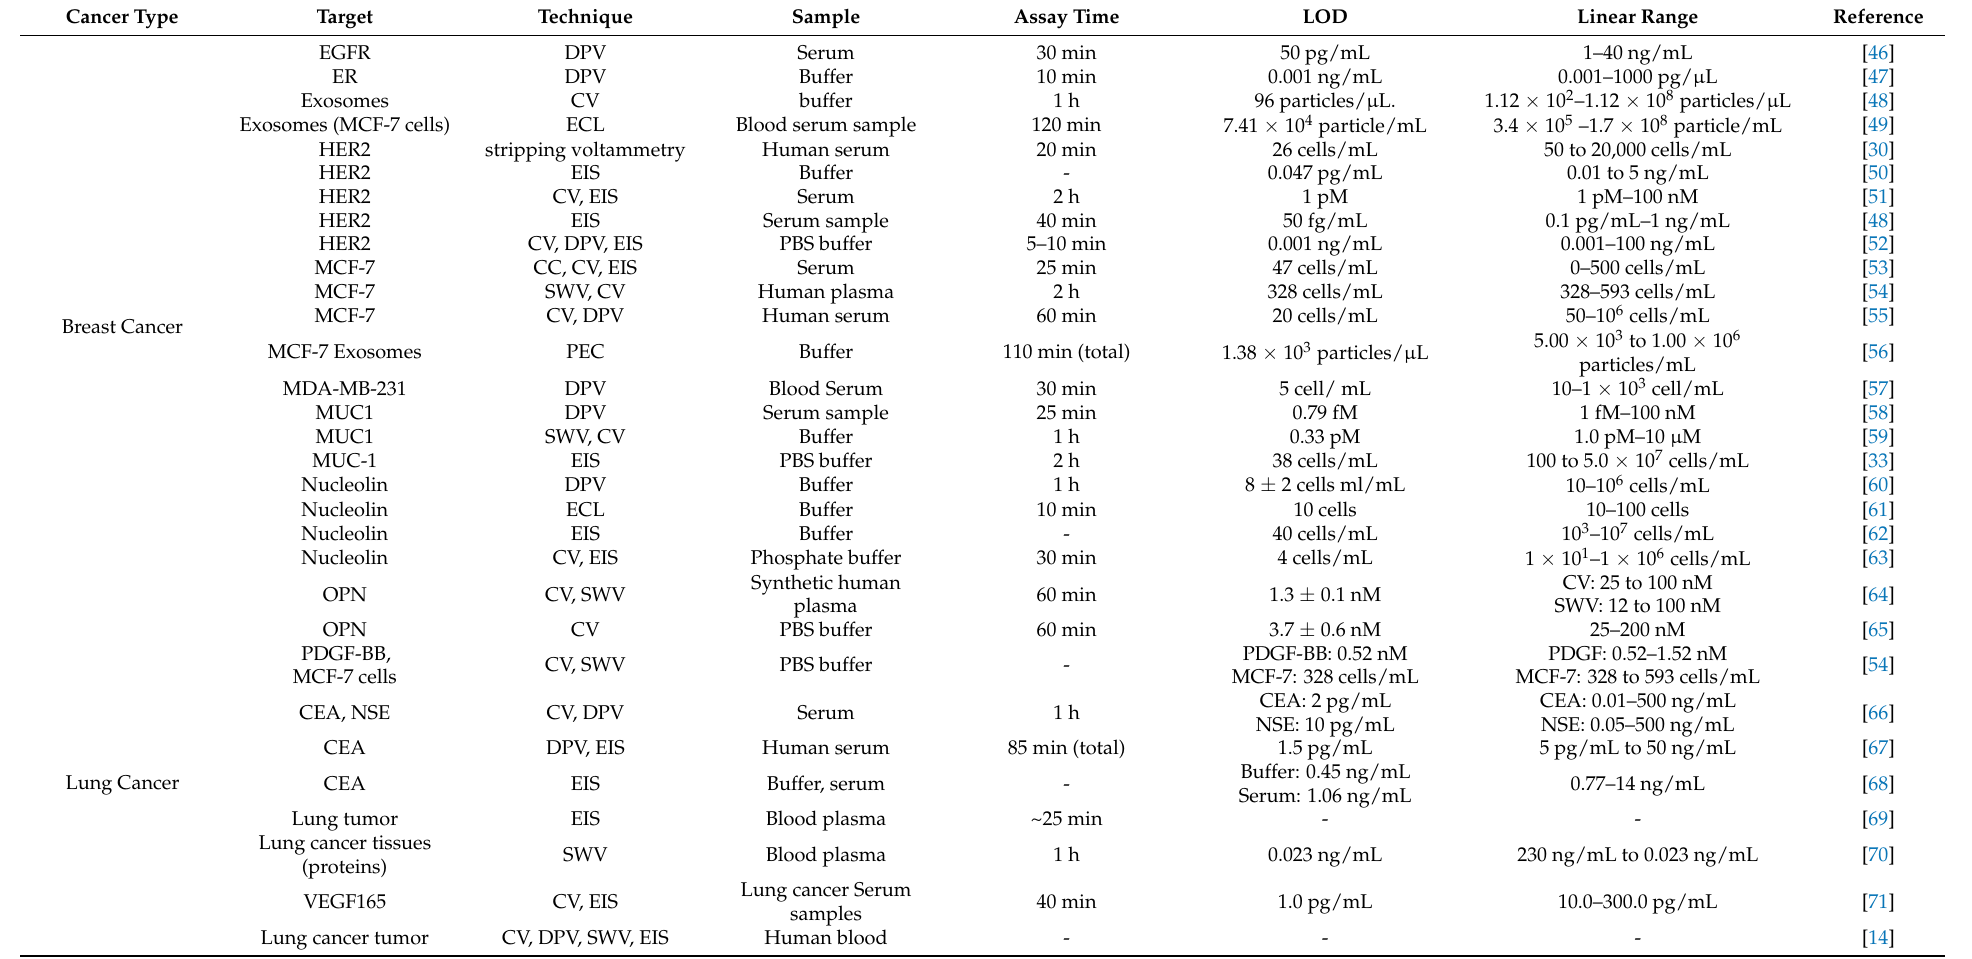
Table 1. Various Electrochemical Aptasensors for cancer detection